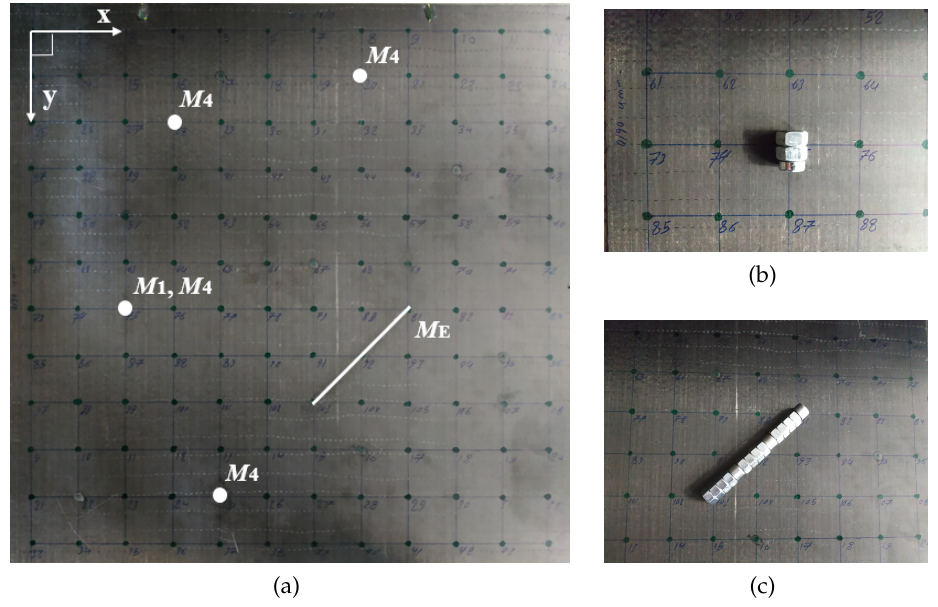
Figure 2. Experimental setup. ( a ) The composite plate with the selected imaging points and damage configurations M 1 : 1 point-like mass, M 4 : 4 point-like masses, M E : 1 extended mass. ( b ) The implementation of a point-like mass. ( c ) The implementation of the extended